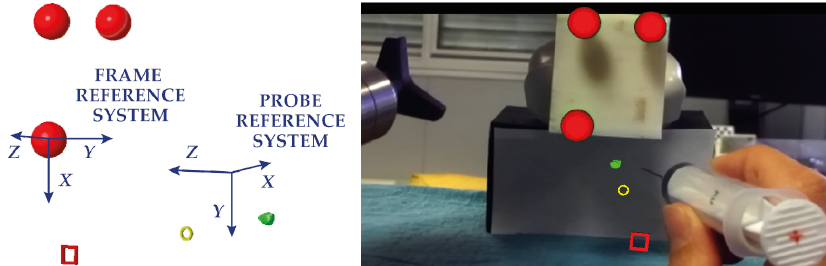
Figure 10. Augmentation of the real scene. On the ( left ), the 3D CAD modelling of the virtual elements used to augment the real scene. On the ( right ), the AR image visualized through the